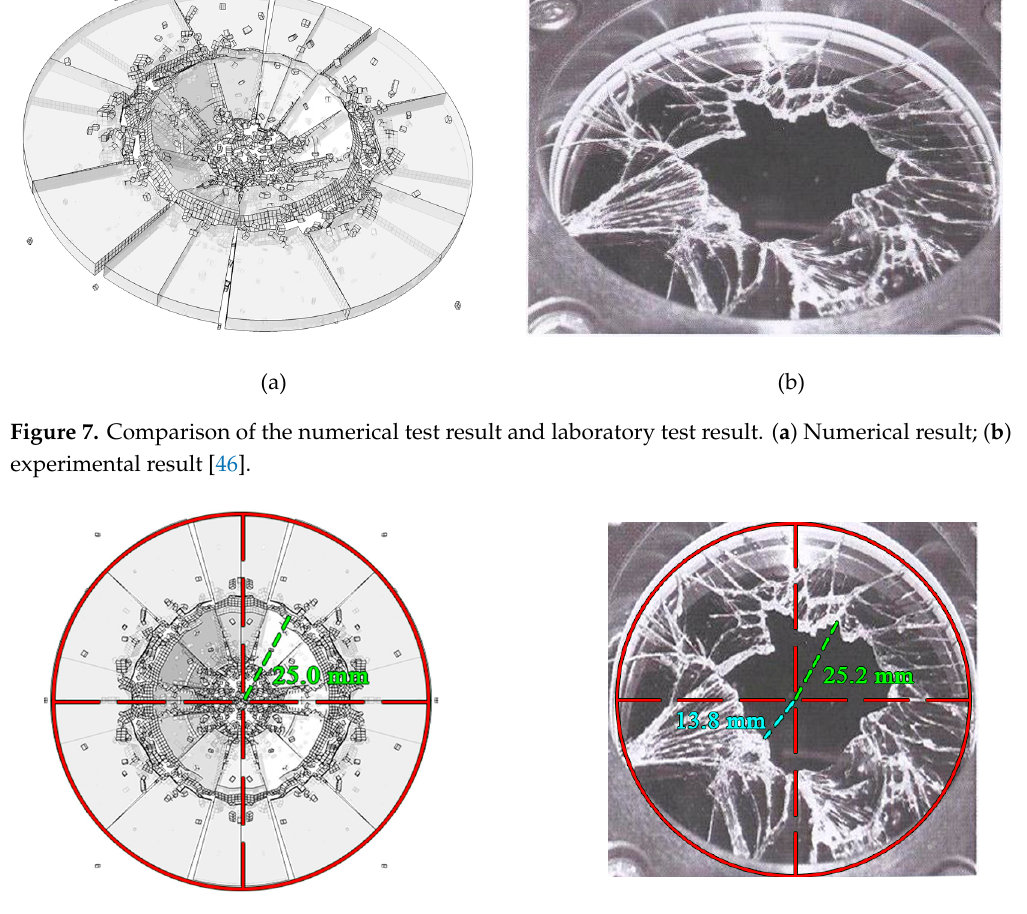
Figure 7. Comparison of the numerical test result and laboratory test result. ( a ) Numerical result; ( b ) experimental result [46].